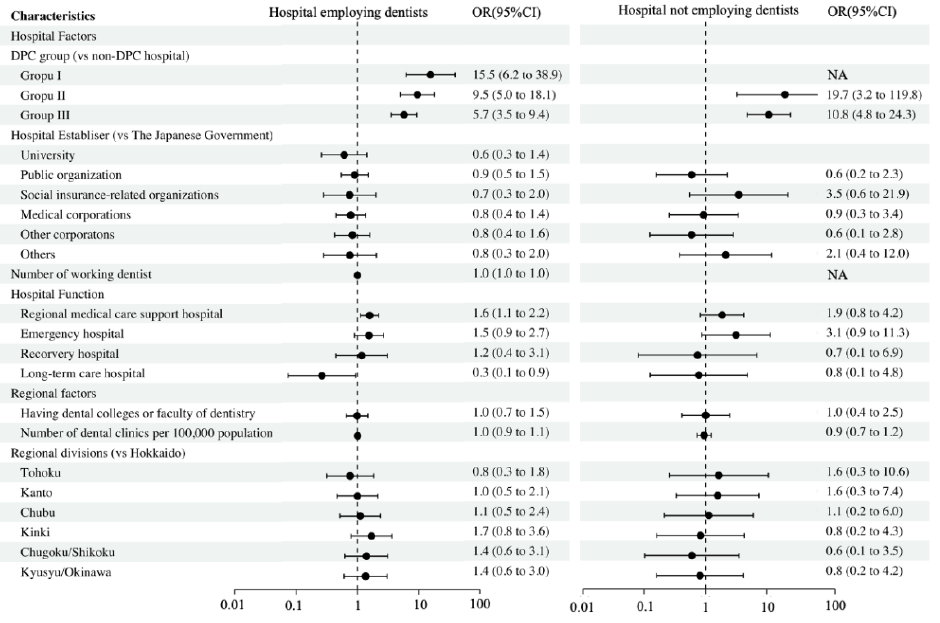
Figure 3. Factors associated with hospitals providing a nutrition support team based on dentist employment status. Abbreviations: OR, odds ratio; 95% CI, 95% confidence interval.